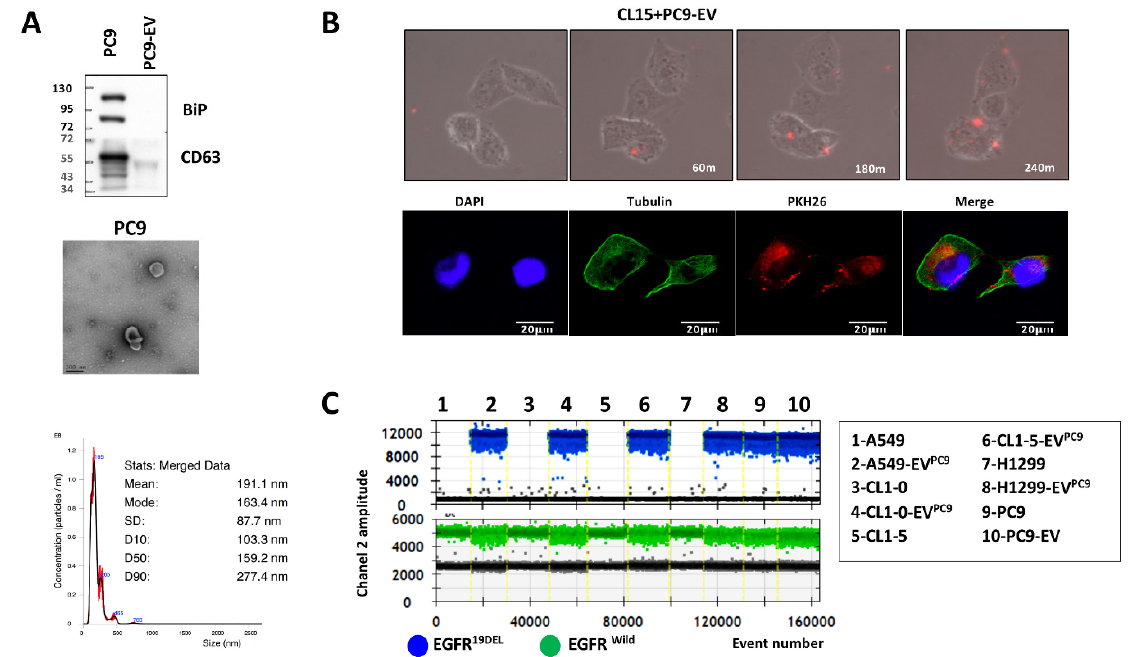
Figure 1. The characteristics of extracellular vesicles and their transfer from PC9 cells to CL1-5 cells. ( A ) The presence of CD63 in isolated extracellular vesicles from PC9 cells was analyzed by Western blot (upper). Extracellular vesicles were observed by transmission electron microscopy (middle). Scale bar, 200 nm. NanoSight particle analysis of extracellular vesicles derived from PC9 cells (lower). ( B ) Time-lapse images following the addition of PKH26-labeled extracellular vesicles to CL1-5 cells and immunostaining showing red fluorescence (EV-PKH26) inside tubulin-positive cells. ( C ) epidermal growth factor receptor (EGFR)-mutant DNA was detected using droplet digital PCR (ddPCRTM; Bio-Rad) in PC9 cells, extracellular vesicles (EVs) from PC9 cells, and EGFR wild-type cells after treatment with PC9 EVs.